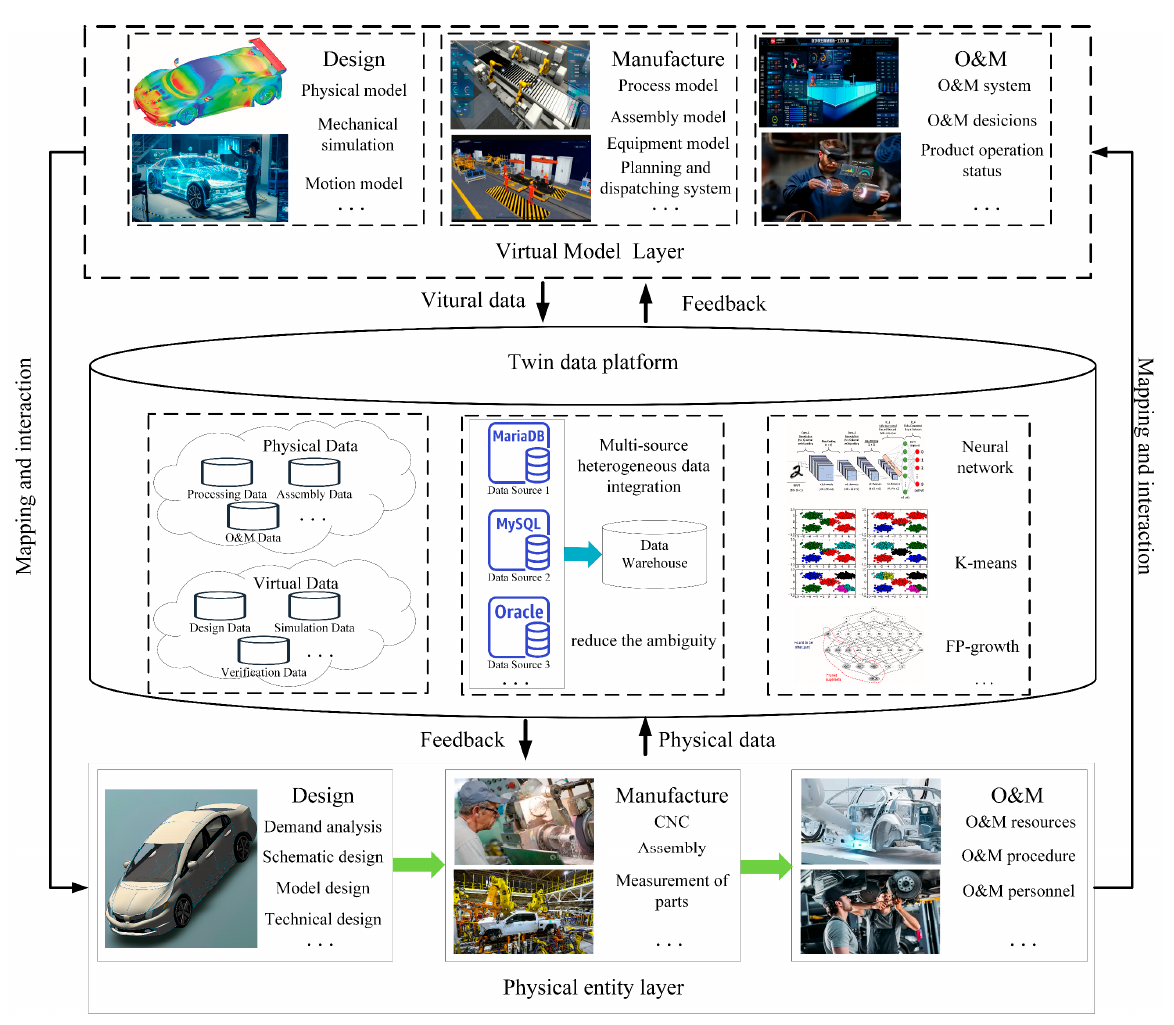
Figure 1. Digital twin ‐ driven integrated design ‐ manufacturing ‐ O&M model for complex products.